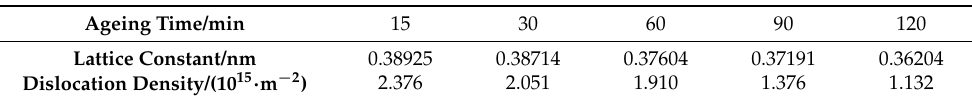
Figure 4. TEM images after ageing at 450 °C under different holding times: ( a ) 15 min; ( b ) 30 min; ( c ) 60 min; ( d ) 90 min; ( e ) 120 min; ( f ) SAED of the square area in ( e ). Table 2. Lattice distortion and dislocation density after ageing at 450 °C under different holding times.